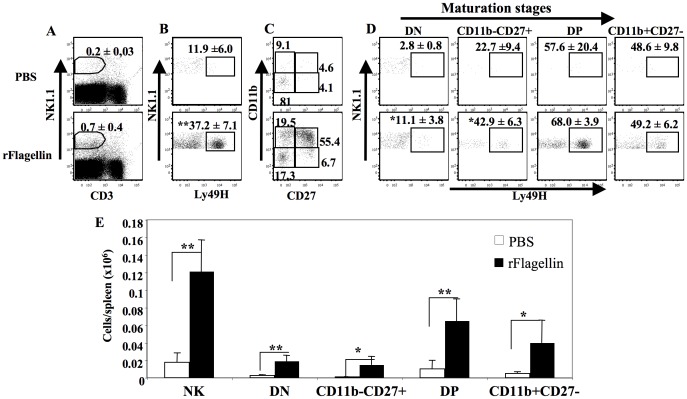
rFlagellin treatment enhanced maturation and increased expression of Ly49H on NK cells after mCMV infection.Harvested splenocytes on day 3 after mCMV infection from rflagellin- and PBS-treated control mice were stained with mAbs to NK1.1, CD27, CD11b along with Ly49H as described in Materials and Methods. A. FACS plots of % CD3-NK1.1+ NK cells of lymphocyte-gated populations. B. % Ly49H expressed by NK cells. C. CD11b−CD27−(DN), CD11b−CD27+, CD11b+CD27+ (DP) and CD11b+CD27− NK cell populations. D. Ly49H+ NK cells of 4 subsets gated populations described in C. E. The total numbers of Ly49H+ NK cells and all 4 subsets of NK cells (as described in D) per spleen expressed Ly49H on day 3 after mCMV infection. The “*” represents p value<0.05, Student's T-test. 5 mice were used per group.